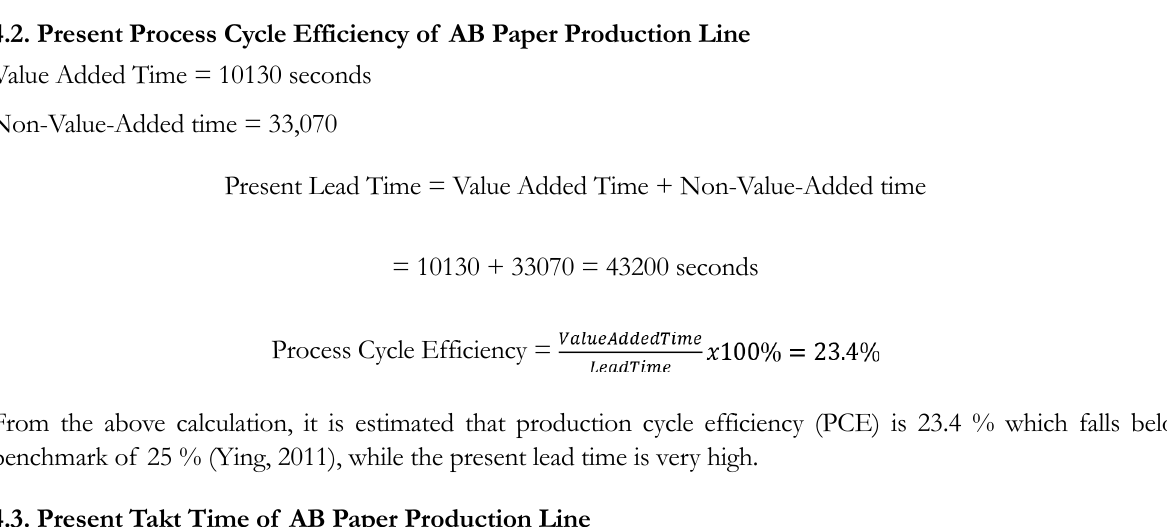
Figure 3. Present Value Stream Mapping of AB Production